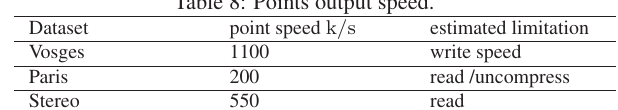
Table 8: Points output